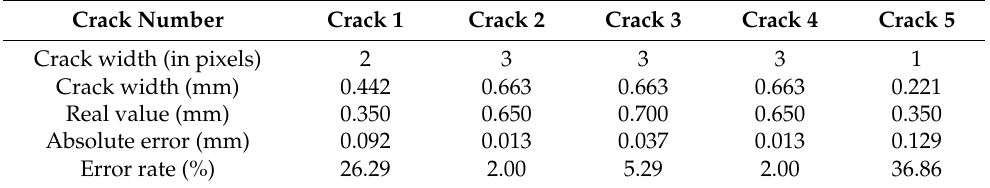
Table 8. Morphological total station measurements (spatial resolution of one pixel: 0.221 mm).